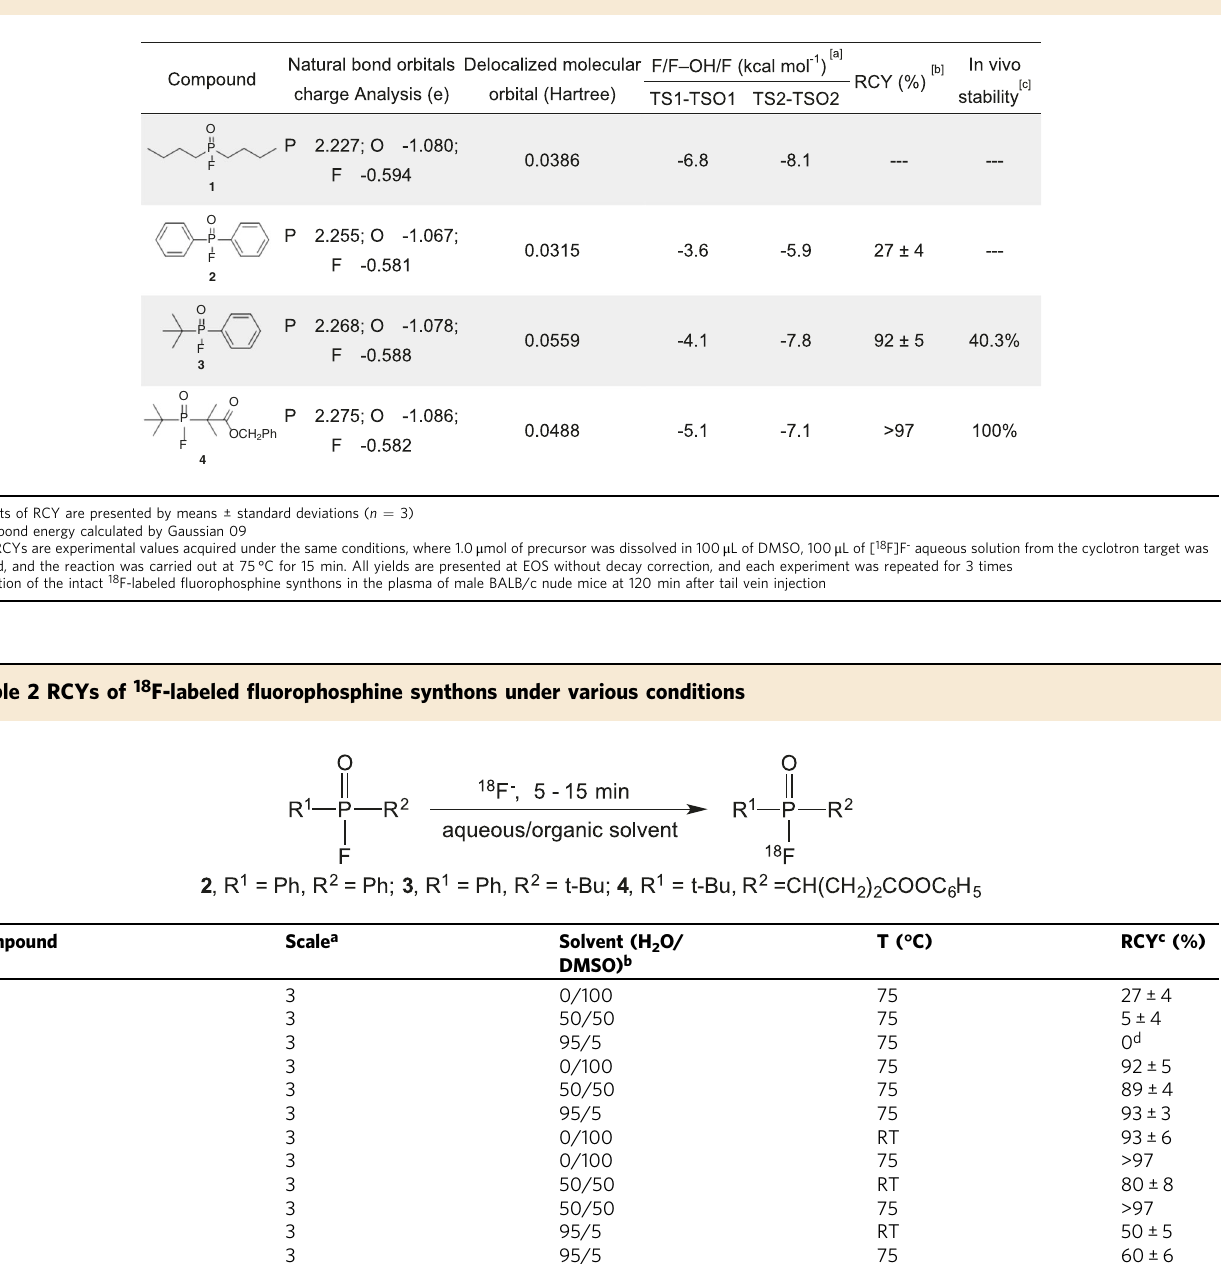
Table 1 Comparison of fl ourophosphines with various degrees of steric hindrance